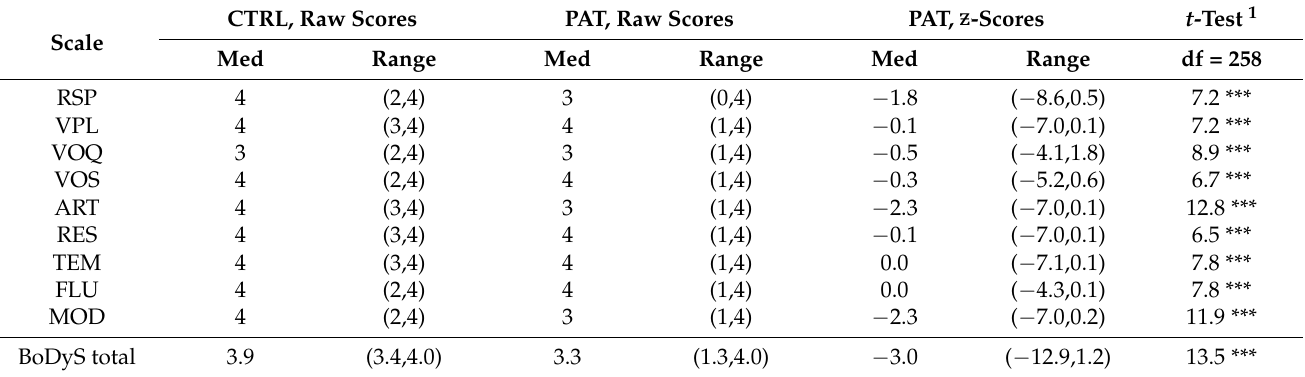
CTRL, Raw Scores PAT, Raw Scores PAT, Scale